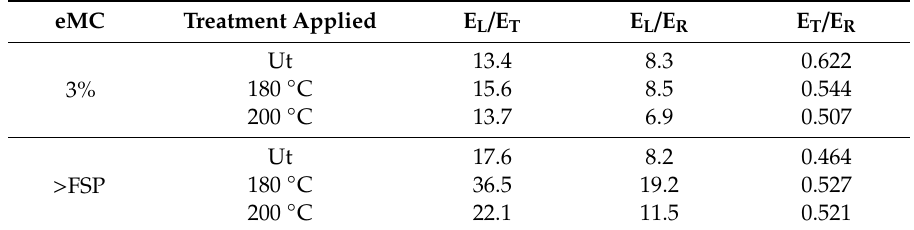
Table 4. Elastic ratios (E) for thermally-modified and unmodified (ut) ash equilibrated to achieve di ff erent moisture content